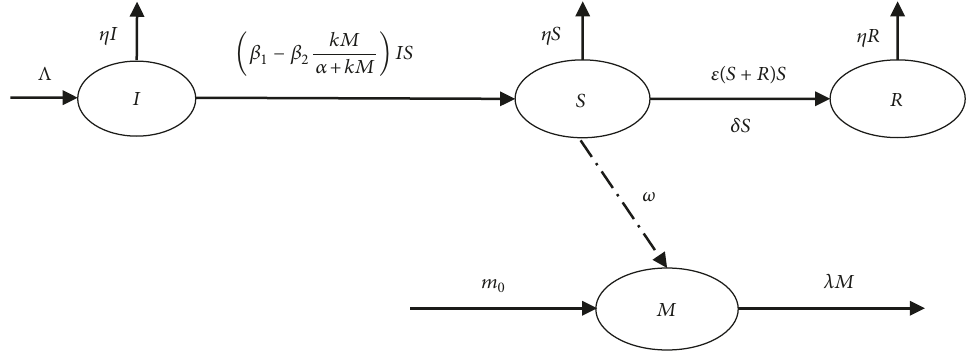
Figure 1: Schematic diagram of rumor spreading under the influence of media coverage and emergency strategies.